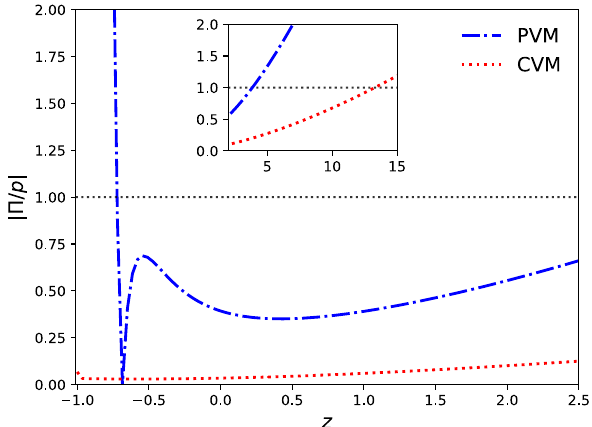
Fig. 6 Evolution of the quotient | (cid:10)/ p | over z , in the redshift region − 1 < z < 2 . 5 and 2 . 5 < z < 15 for the inner panel. The PVM and CVM are represented by blue dot-dashed line and red dotted line